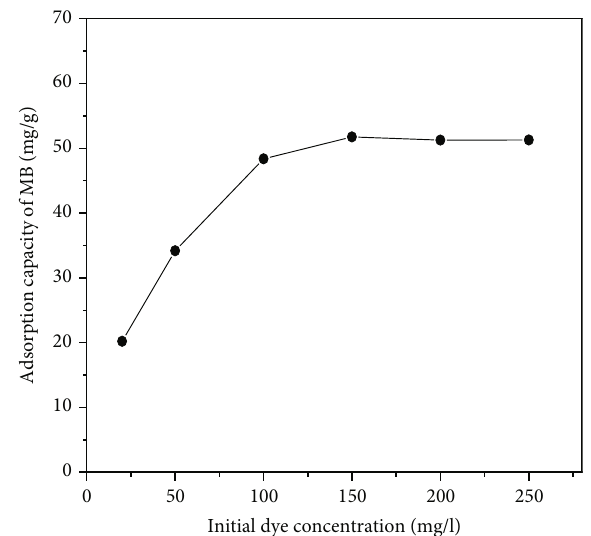
Figure 6: E ff ect of initial dye concentration on removal of MB (pH 10, adsorbent dosage 2 g, and contact time 60 min).